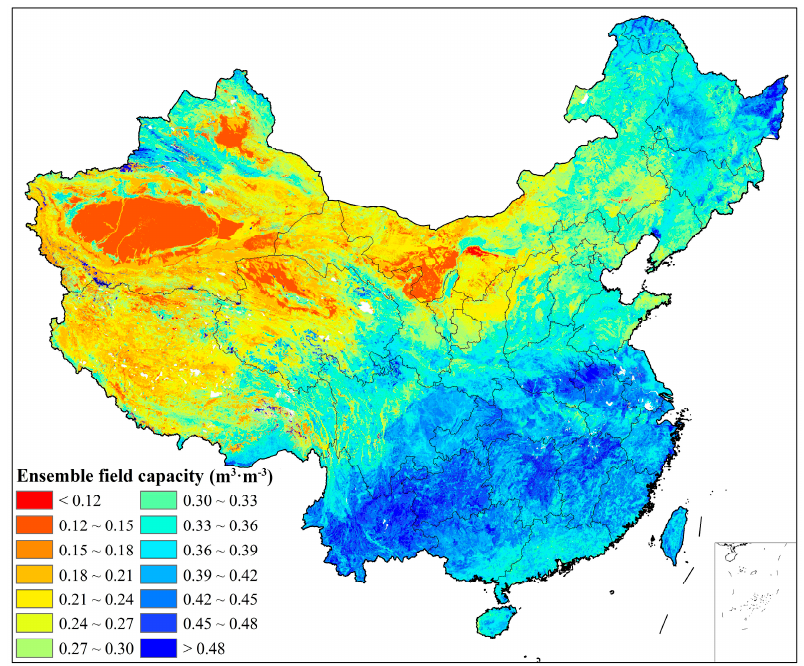
Figure 5. Distribution of ensemble field capacity in China. Field capacity is mapped in a 250 × 250 m grid cell.